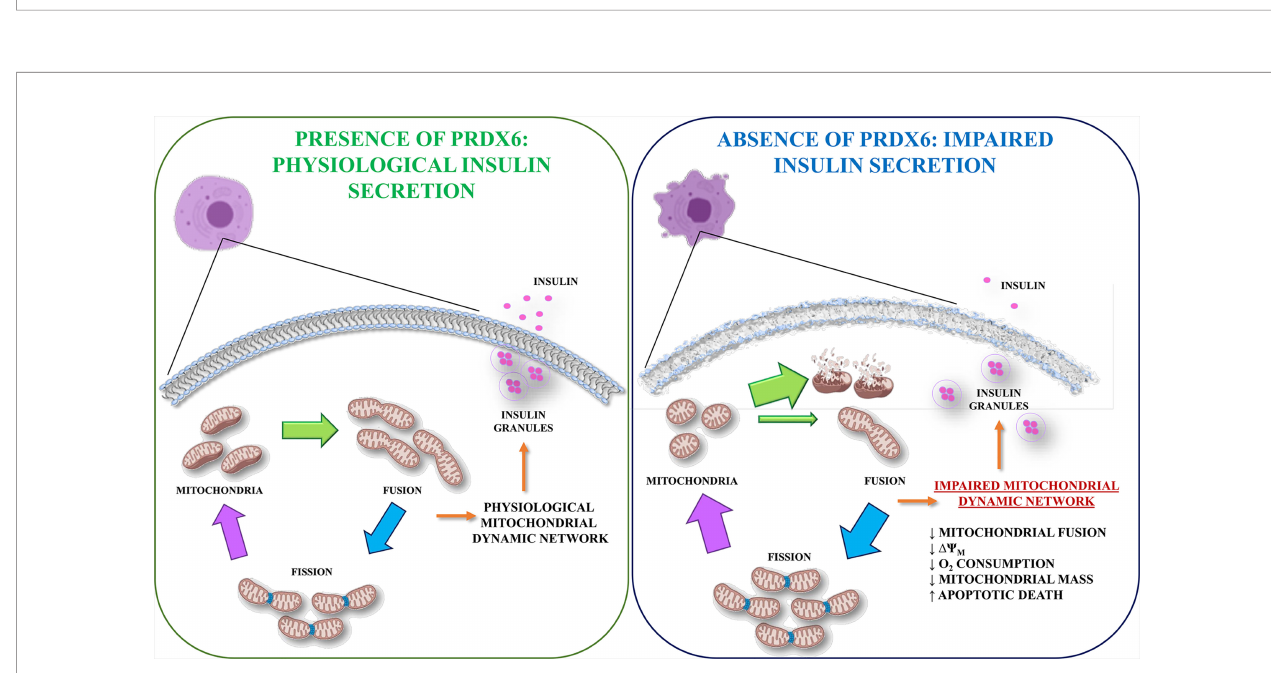
FIGURE 8 | Graphical representation of Prdx6 in the regulation of GSIS. In the presence of Prdx6 mitochondria showed their physiological dynamic network leading to glucose-stimulated insulin secretion (GSIS). However, in the absence of Prx6, the mitochondrial network impairment promotes beta cell dysfunction with altered insulin secretion and beta cell apoptotic